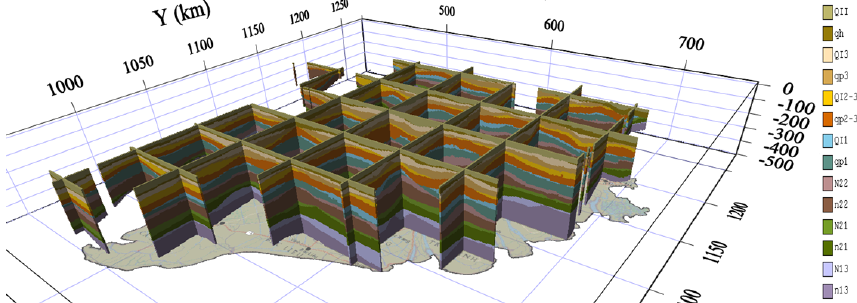
Figure D1. Cross sections through the updated hydrogeological model. Scale according to kilometre reading along the axis (km) and depth in metres. Vertical exaggeration: 100 × ; aquifers (lower-case names) and aquitards (upper-case